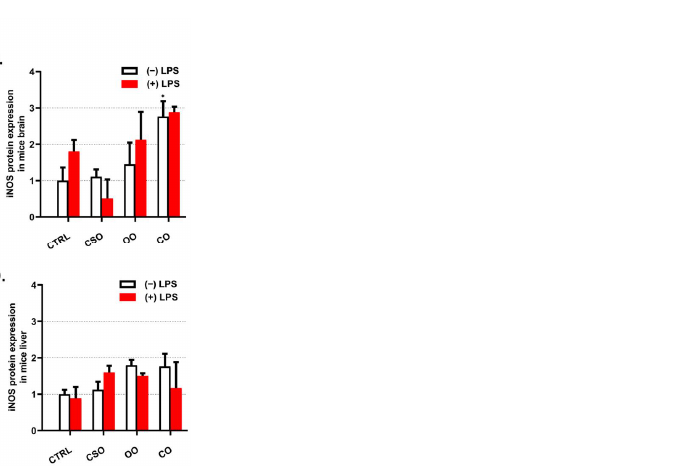
Figure 3. Effect of cactus seed oil, olive oil, or colza oil treatment on protein expression of the iNOS in the brain ( A ) and liver ( C ), respectively. Male C57BL/6 mice received for 28 days a standard diet (control (CTRL)), a diet enriched with 6% ( w / w ) CSO, OO, or CO, and intravenous injection of LPS (100 µg) four hours antemortem. Brain and liver homogenates were separated in PAGE-SDS elec- trophoresis and subjected to immunoblotting as described in Material and Methods section. Im- munoblots were performed in triplicate and here we showed a representative blot. The iNOS 130 kDa band intensities were analyzed by densitometry and standardized to α-tubulin (55 kDa) ex- pression level in brain ( B ) and in liver ( D ). All values are means ± SD (n = 3) of 3 independent rep- licates. Statistical significance of higher mean signal strength (* p ≤ 0.05) compared to control, com- pared to LPS, and compared to the different treatments with or without LPS administration. Statis- tics were executed using two-way ANOVA followed by Tukey test for multiple comparisons.